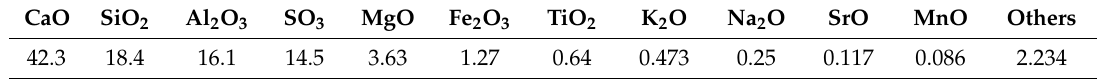
Table 1. Chemical compositions of SAC